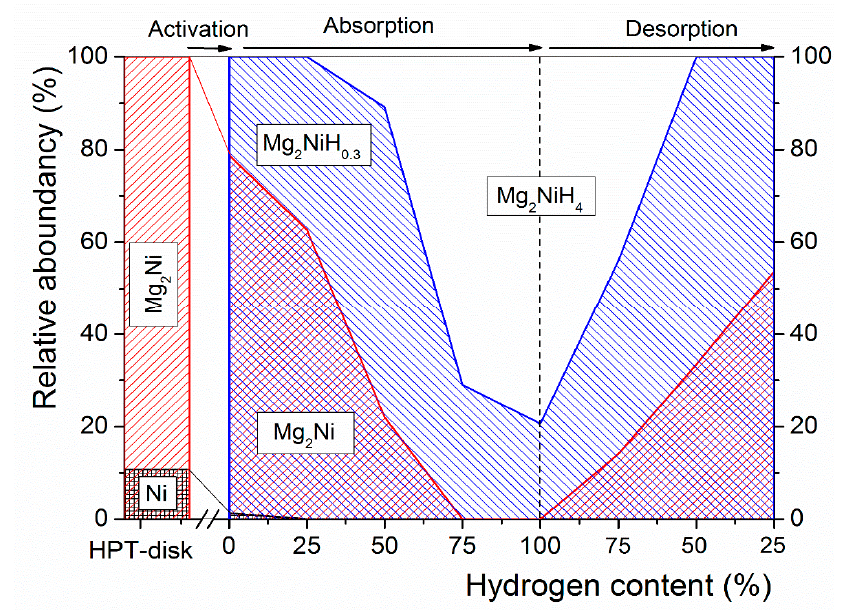
Figure 5. Evolution of phase composition during hydrogenation and dehydrogenation of the Mg- Ni HPT-disk [77]. HPT-disk